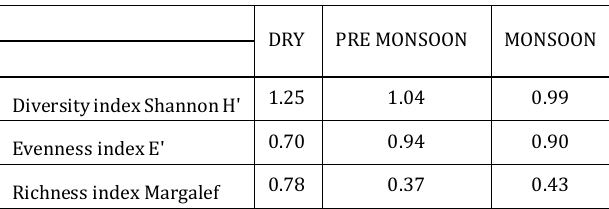
Table 6: Diversity indices at Station 3